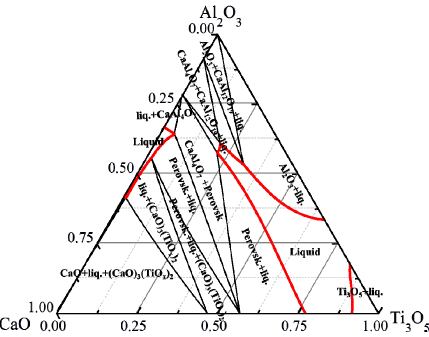
lines are liquiduses at 1873 K. As shown in Figure 4a, the inclusions in No.1 melt after Ti addition are